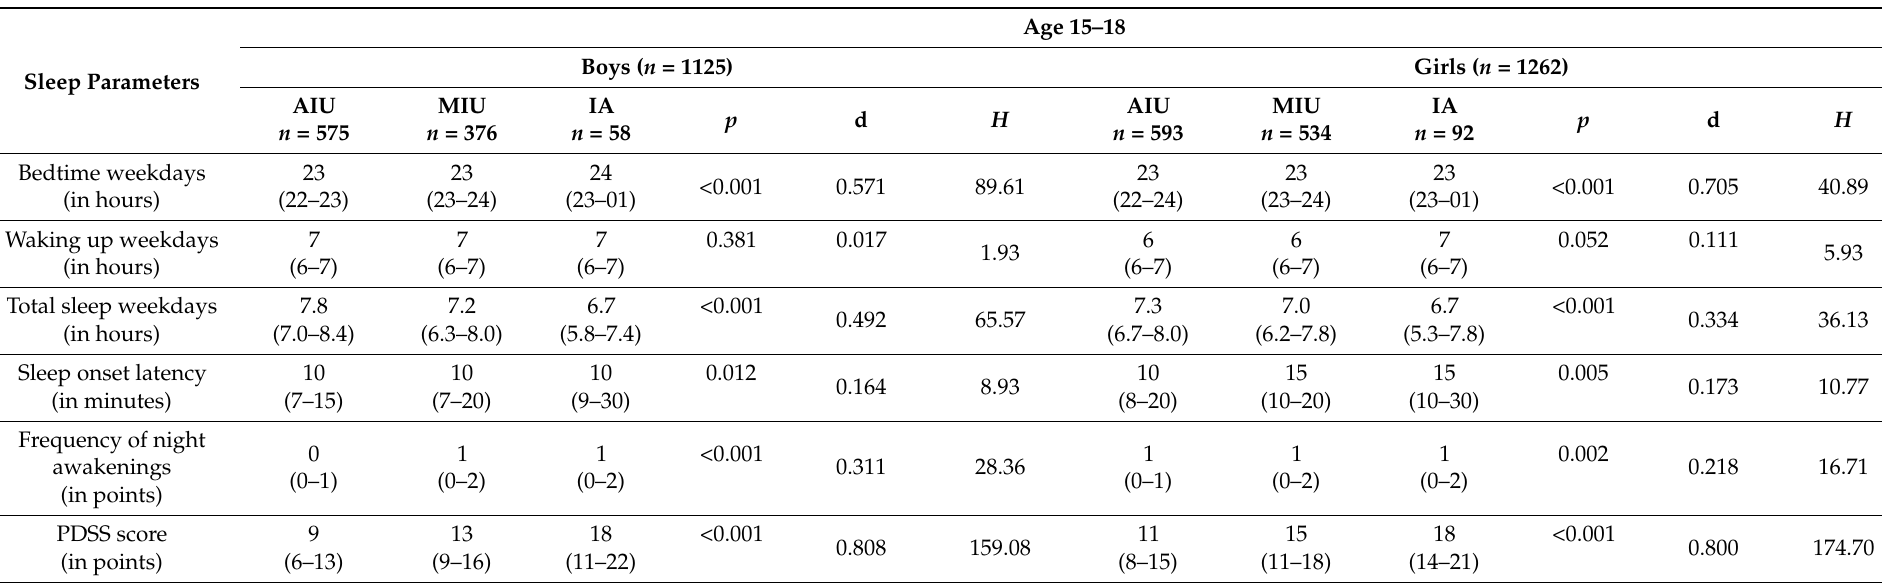
Table 4. Sleep parameters in adolescents aged 15–18 with IA verified with Chen Internet Addiction Scale